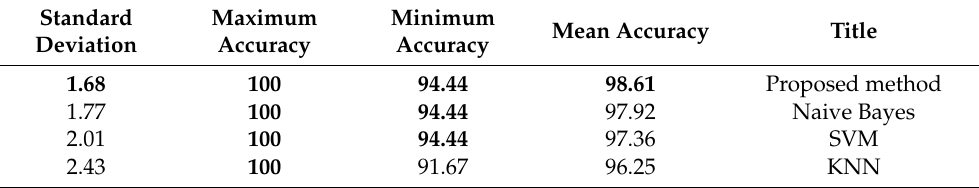
Figure 7. The distribution of samples belonging to each target class based on 3 features extracted by Figure 7. The accuracy of proposed method and other algorithms for 20 repetitions of experiments. the SVD algorithm in BRATS2014 . Table 3. Summary of the detection results of the proposed method and each of the algorithms used in it.